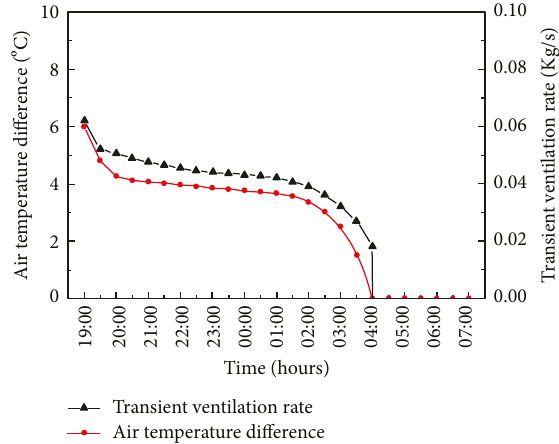
Figure 6: Variation of air temperature and ventilation rate for phase change temperature of 44 °